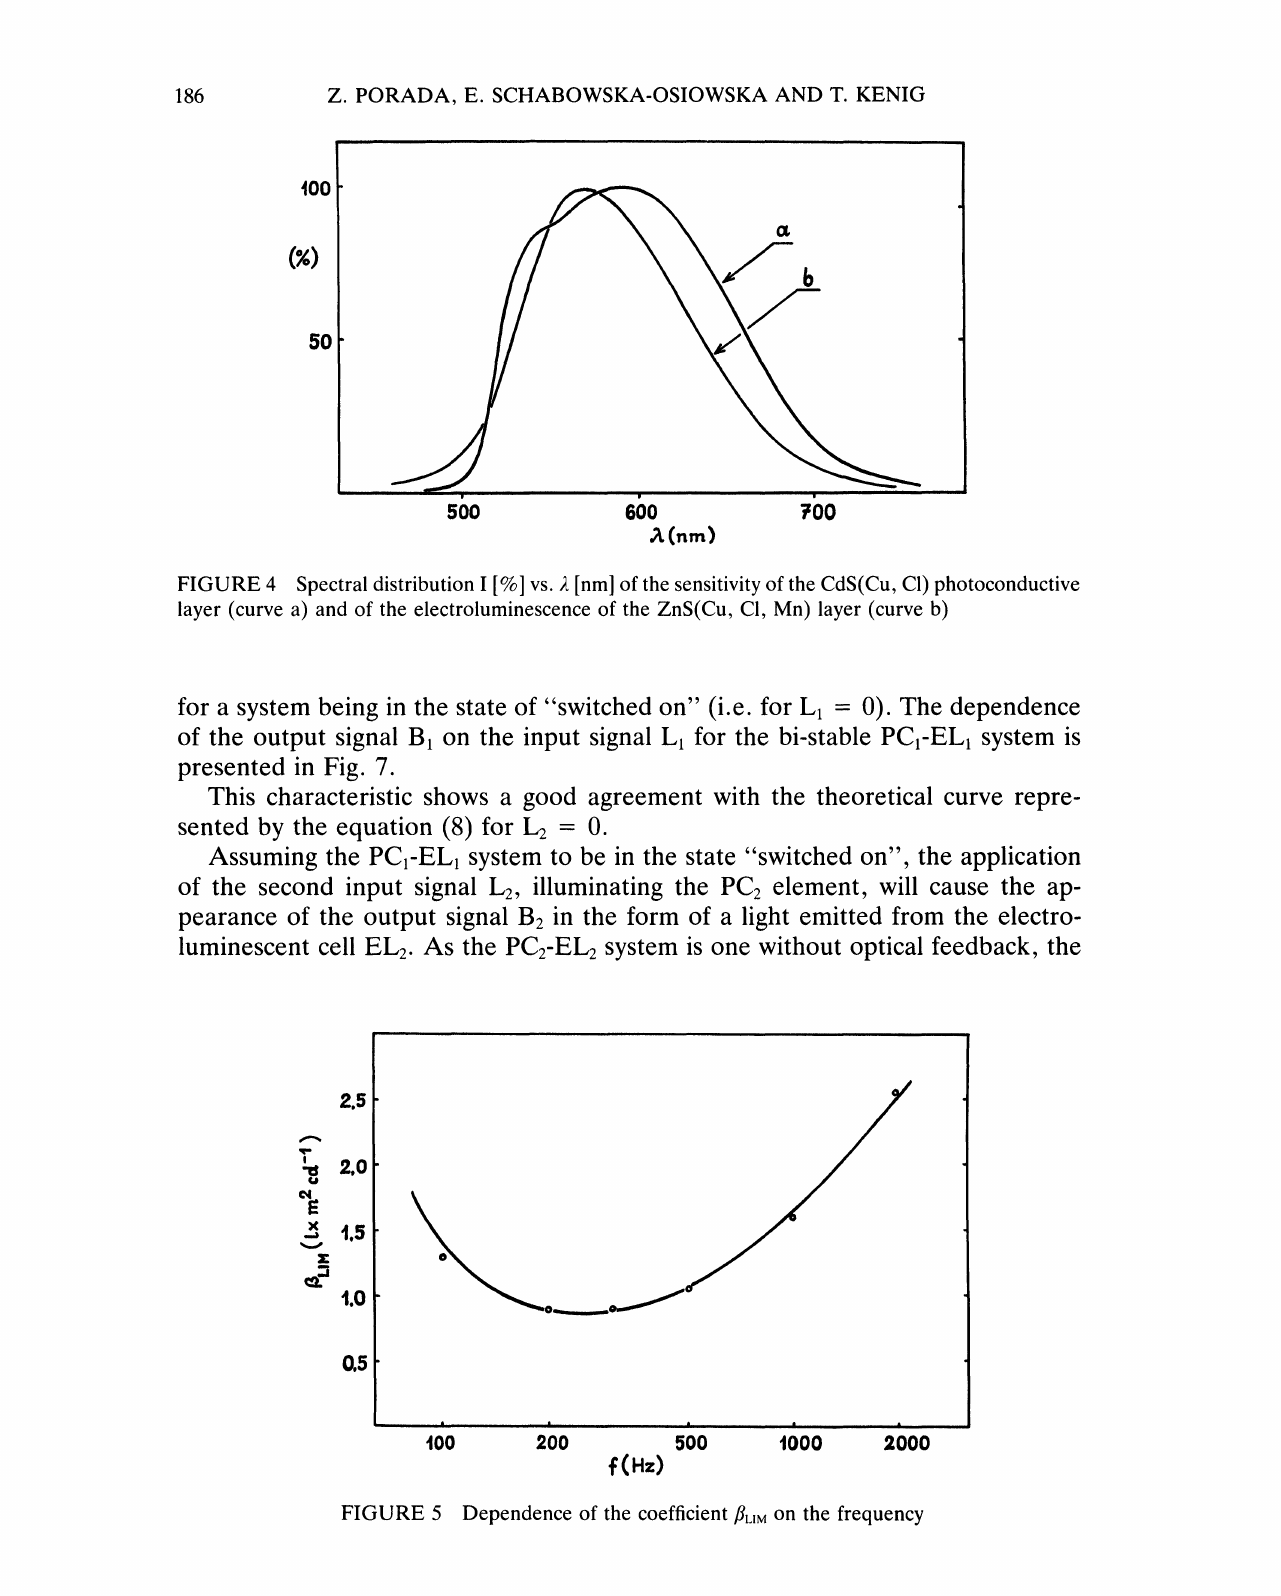
FIGURE 5 Dependence of the coefficient LIM on the